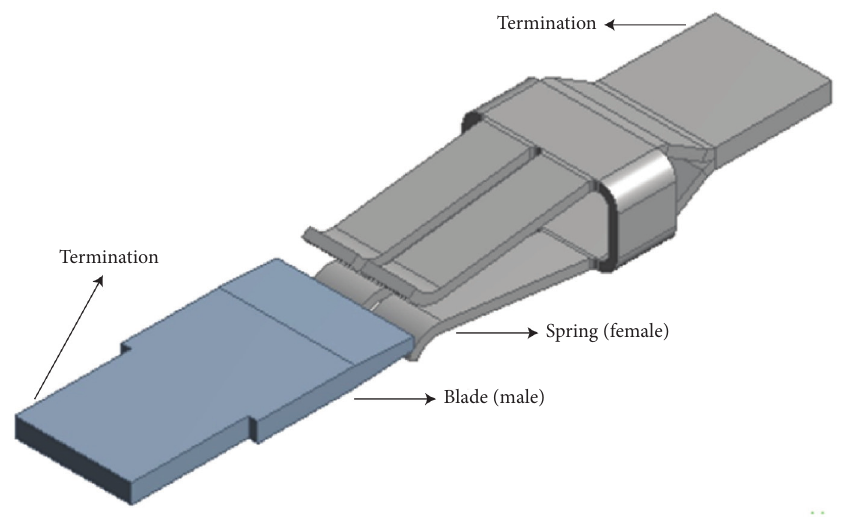
Figure 2: Analysis object: a spring-blade